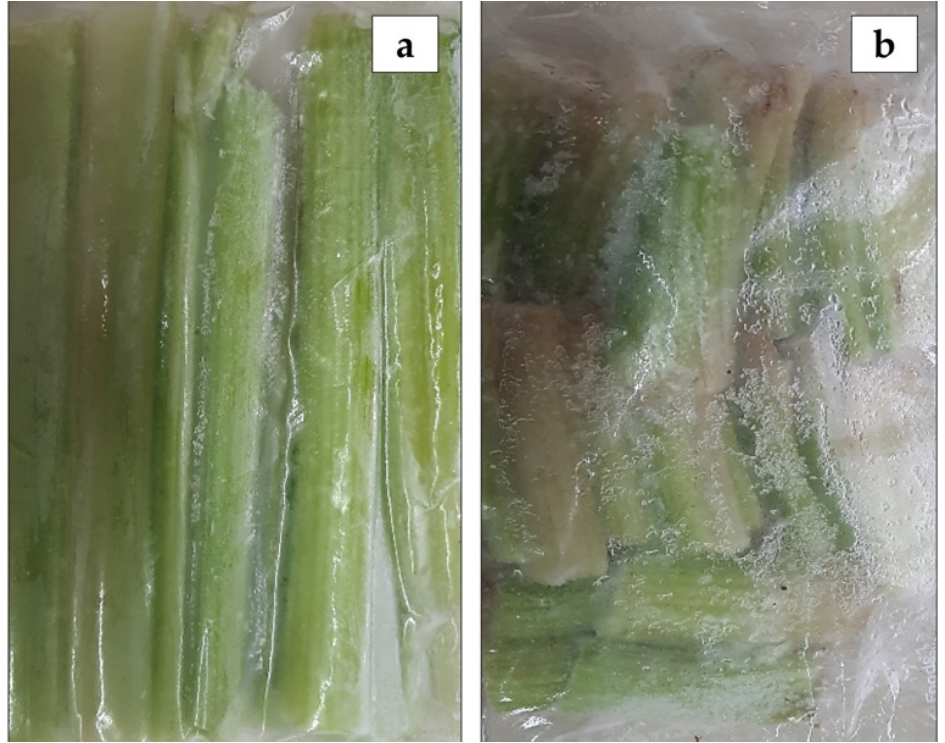
Figure 1. Celery by-products used in this study: ( a ) stalk; ( b ) root.